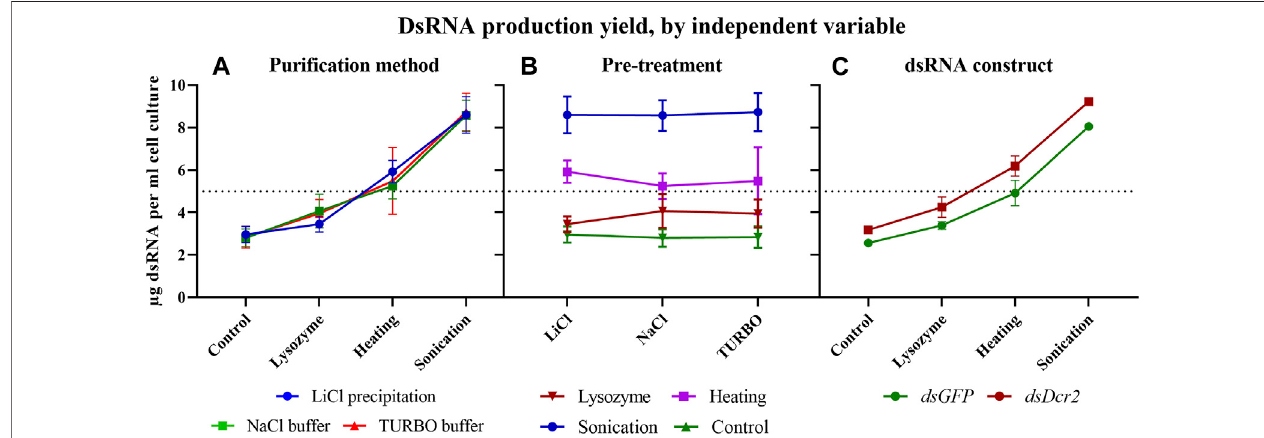
FIGURE 5 | The production yield of dsRNA per ml of bacterial culture is dependent on the pre-treatments applied and the dsRNA construct. The data of Table 2 weresortedasdescribed in Figure4 tovisualizetheimpact oftheexperimentalvariablesondsRNAyield.Symbolsindicatethemean,errorbarsthestandarddeviation. (A) : Puri fi cation methods did not impact the fi nal production yield of dsRNA per ml cell culture ( p = 0.9935). (B) : The pre-treatments had a major effect on the fi nal production yield of dsRNA per ml cell culture ( p < 0.0001). (C) : The dsRNA construct had an impact on the fi nal production yield of dsRNA per ml cell culture ( p = 0.0002). Statistical analysis was performed with a repeated measure two-way ANOVA.